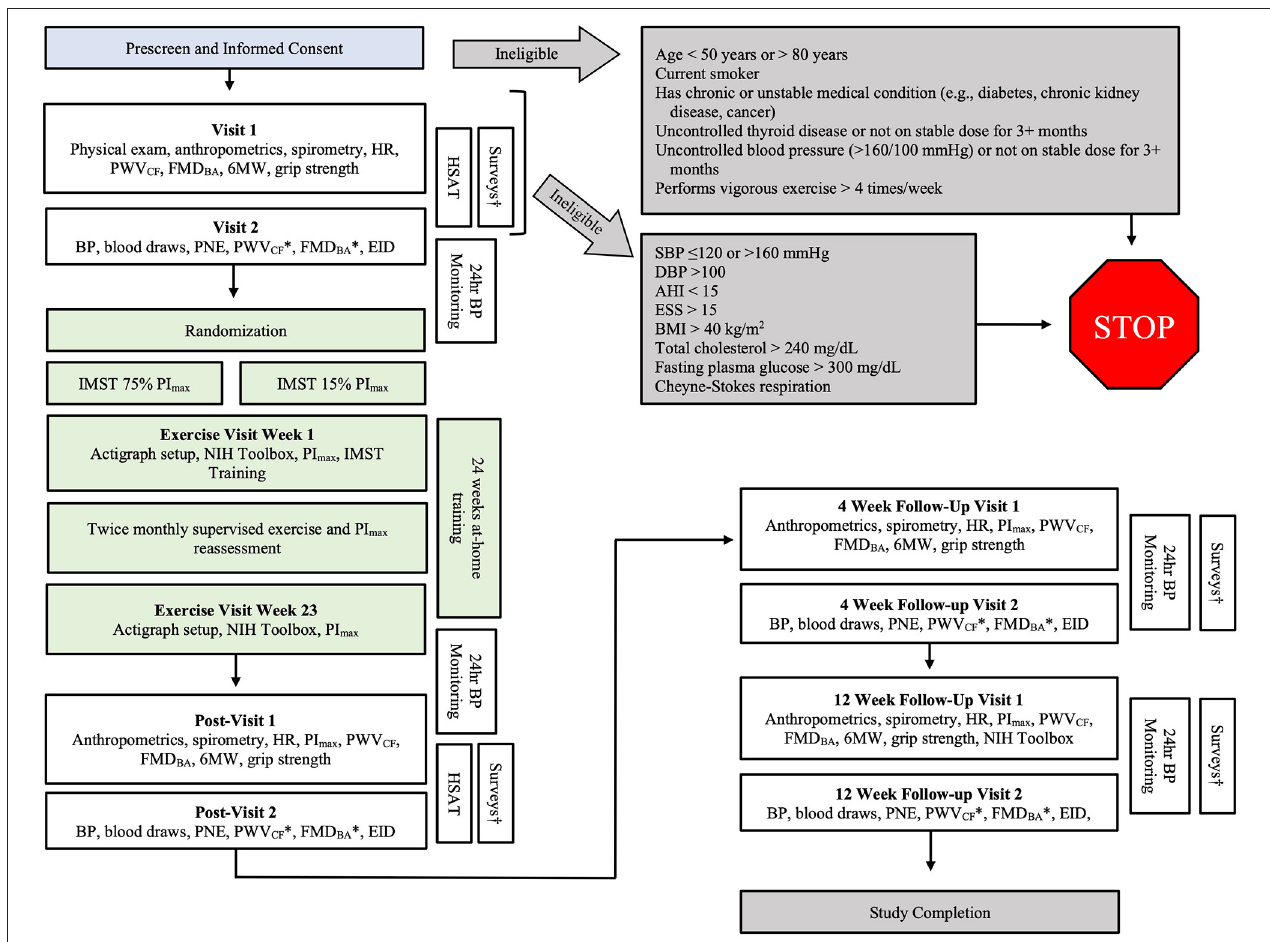
FIGURE 2 | Detailed overview of the CHART study protocol. 6MW, six-minute walk; AHI, apnea hypopnea index; BMI, body mass index; BP, blood pressure; CHAMPS, Community Healthy Activities Model Program for Seniors physical activity questionnaire; ESS, Epworth Sleepiness Scale; FMD BA , brachial artery flow-mediated dilation; HR, heart rate; IMST, inspiratory muscle strength training; PI max , maximal inspiratory pressure; PNE, plasma norepinephrine; PSQI, Pittsburgh Sleep Quality Index; PWV CF , carotid-femoral pulse wave velocity; SBP, systolic blood pressure; *Indicates PWV CF and FMD BA will be performed with saline